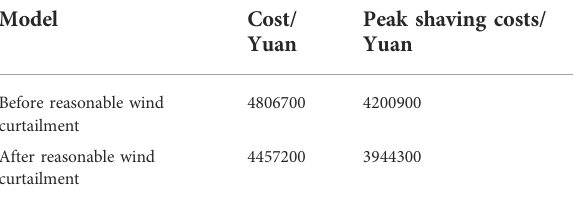
TABLE 3 Calculation results before and after wind